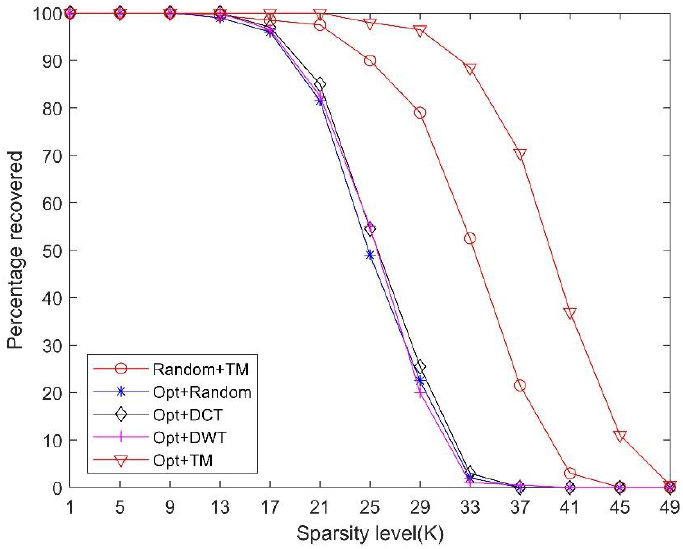
Figure 8. Comparison of the reconstruction performances using different sparsifying dictionaries with the optimized measurement matrix ( M = 64).